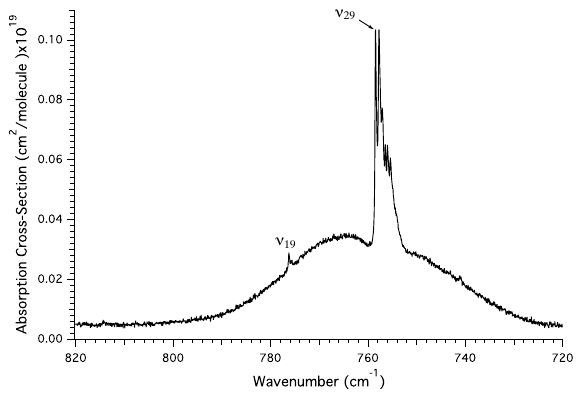
Figure 6. Quantitative infrared spectrum of ν 19 and ν 29 recorded at 298K. Absorption cross sections are given in Naperian units (cm 2 molecule − 1 ) × 10 19 for the composite spectrum recorded at 298K.